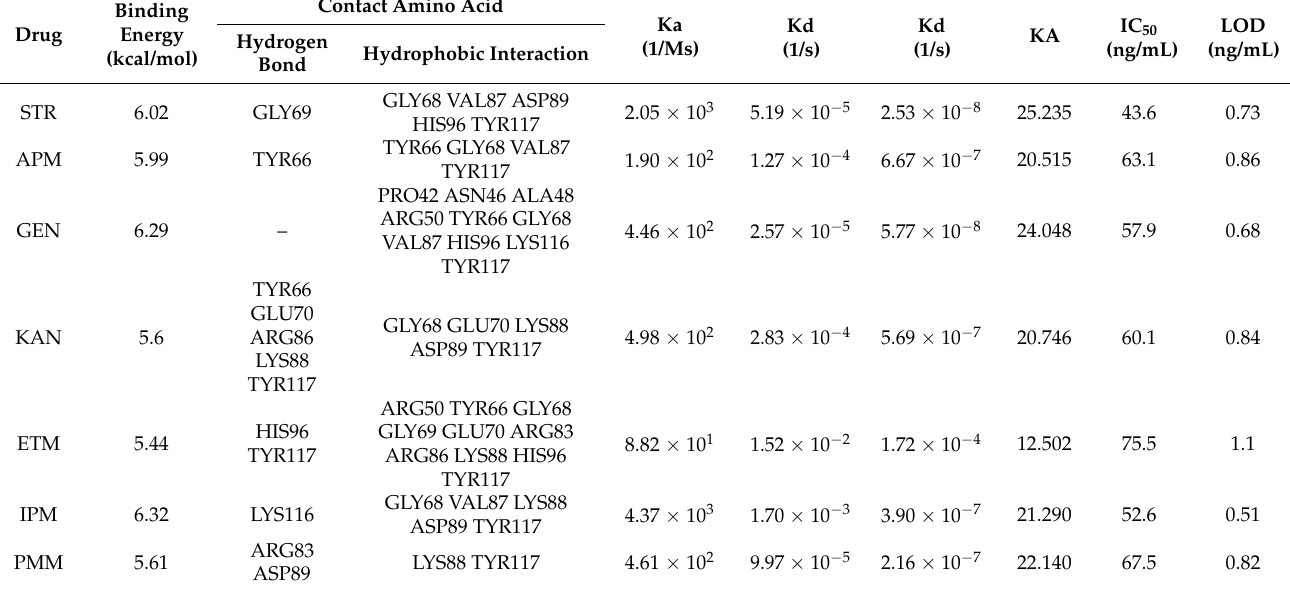
Table 1. Results of molecular docking, affinity, and sensitivity for the 7